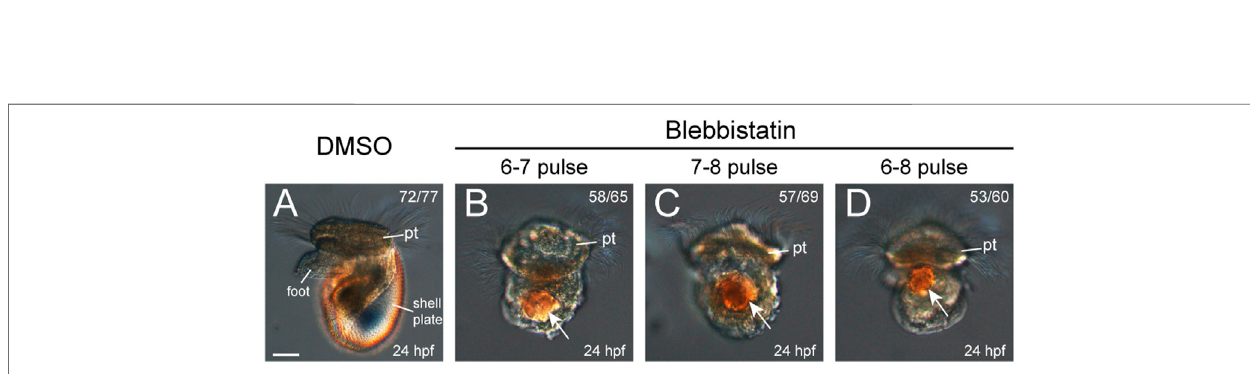
Frontiers in Cell and Developmental Biology |